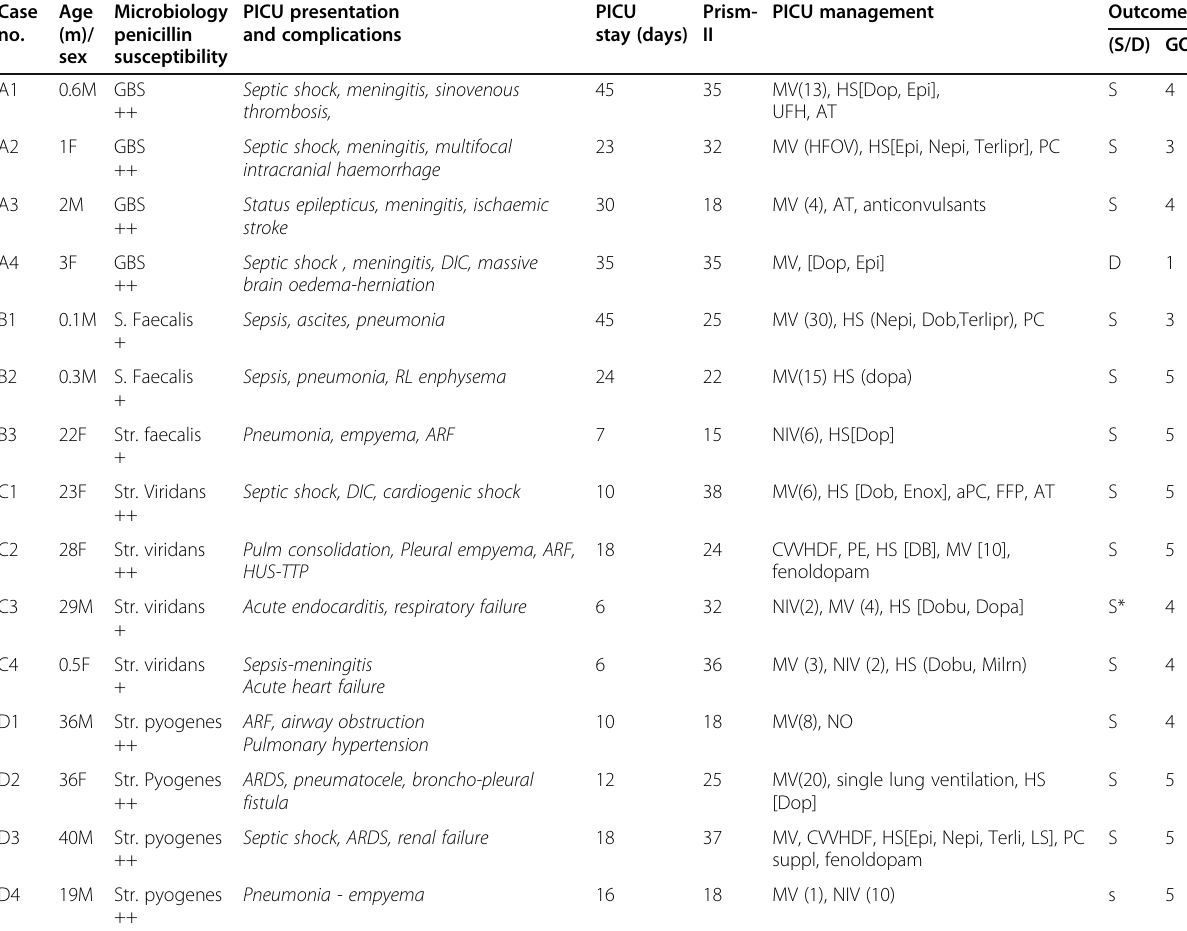
Table 1 Main patient data Case